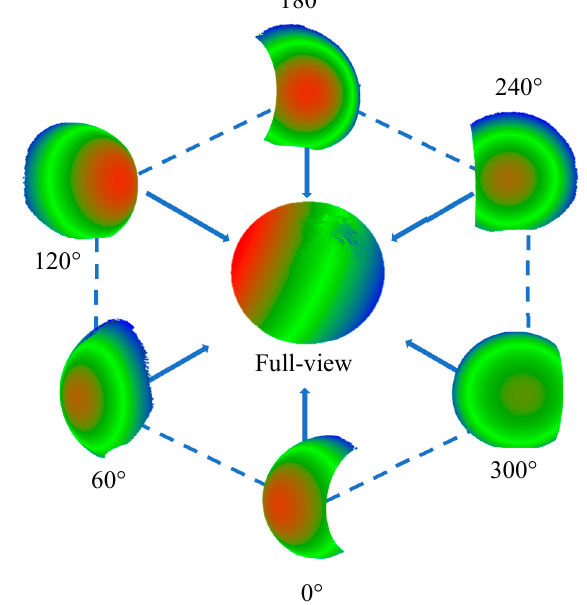
Figure 12. The transformed and aligned spherical point cloud based on 6 views. Because of the measurement range of the sensor, the complete spherical information cannot be scanned at once, and there will be a little loss at the top and bottom.